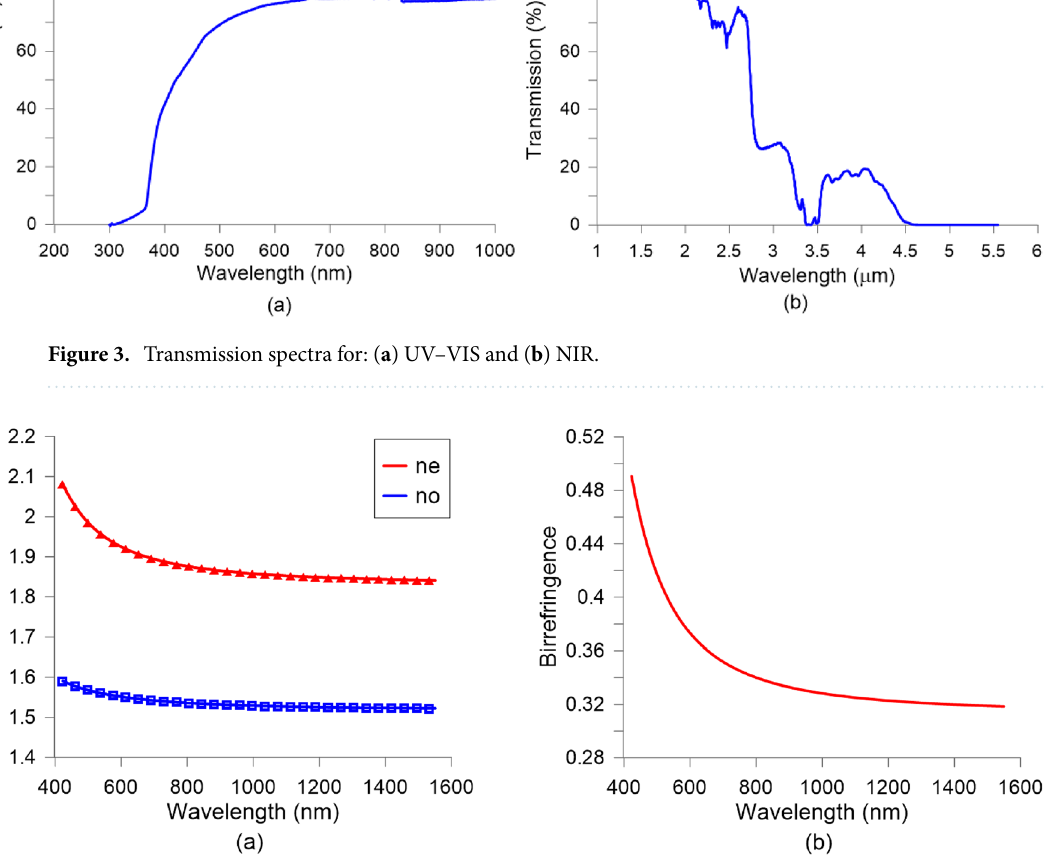
Figure 4. Wavelength dispersion of: ( a ) the extraordinary ( n e ) and ordinary n o LC indices (symbols are experimental data and solid line the Cauchy fit) and ( b ) the LC birefringence ( (cid:31) n = n e − n o